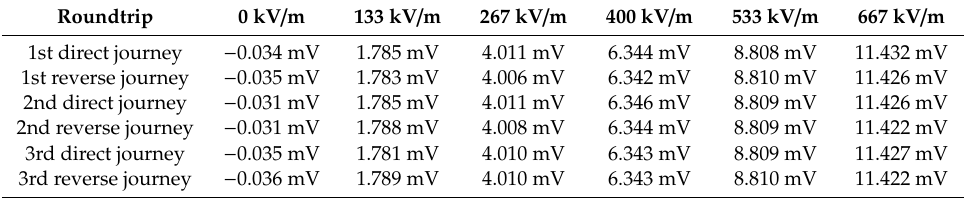
Table 1. The detailed test results of the response characteristics for DC fields.